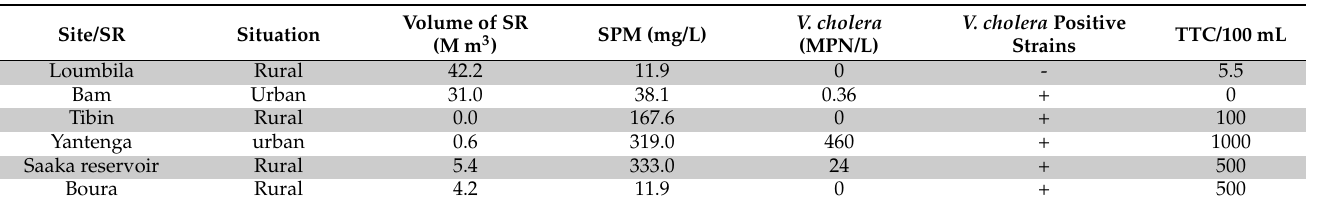
Table 13. The results of the measured parameters of some selected sites sampled between April and June 2014